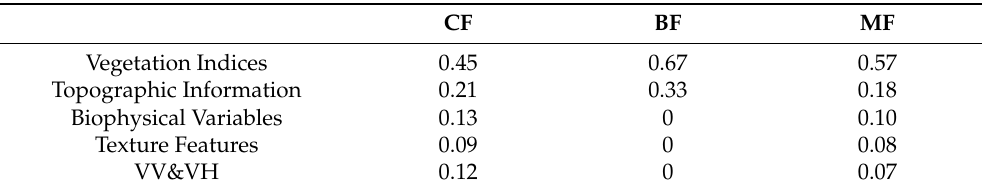
Table 6. Sum of importance scores of variables corresponding to “Vegetation Indices”, “Topographic Information”, “Biophysical Variables”, “Texture Features”, and “VV&VH” for CF, BF, and MF. CF BF MF Vegetation Indices 0.45 0.67 0.57 Topographic Information 0.21 0.33 0.18 Biophysical Variables 0.13 0 0.10 Texture Features